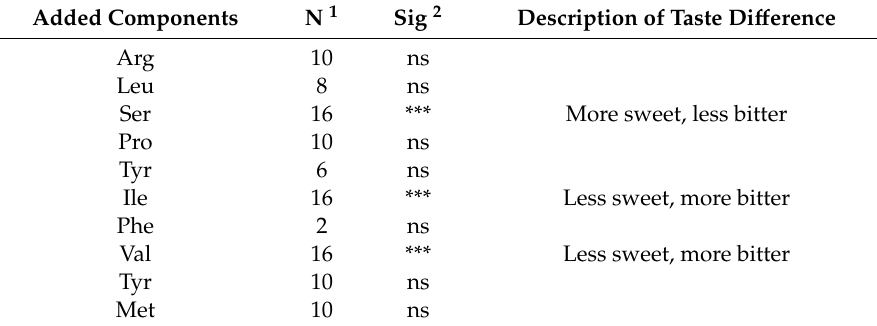
Table 4. Results of the addition